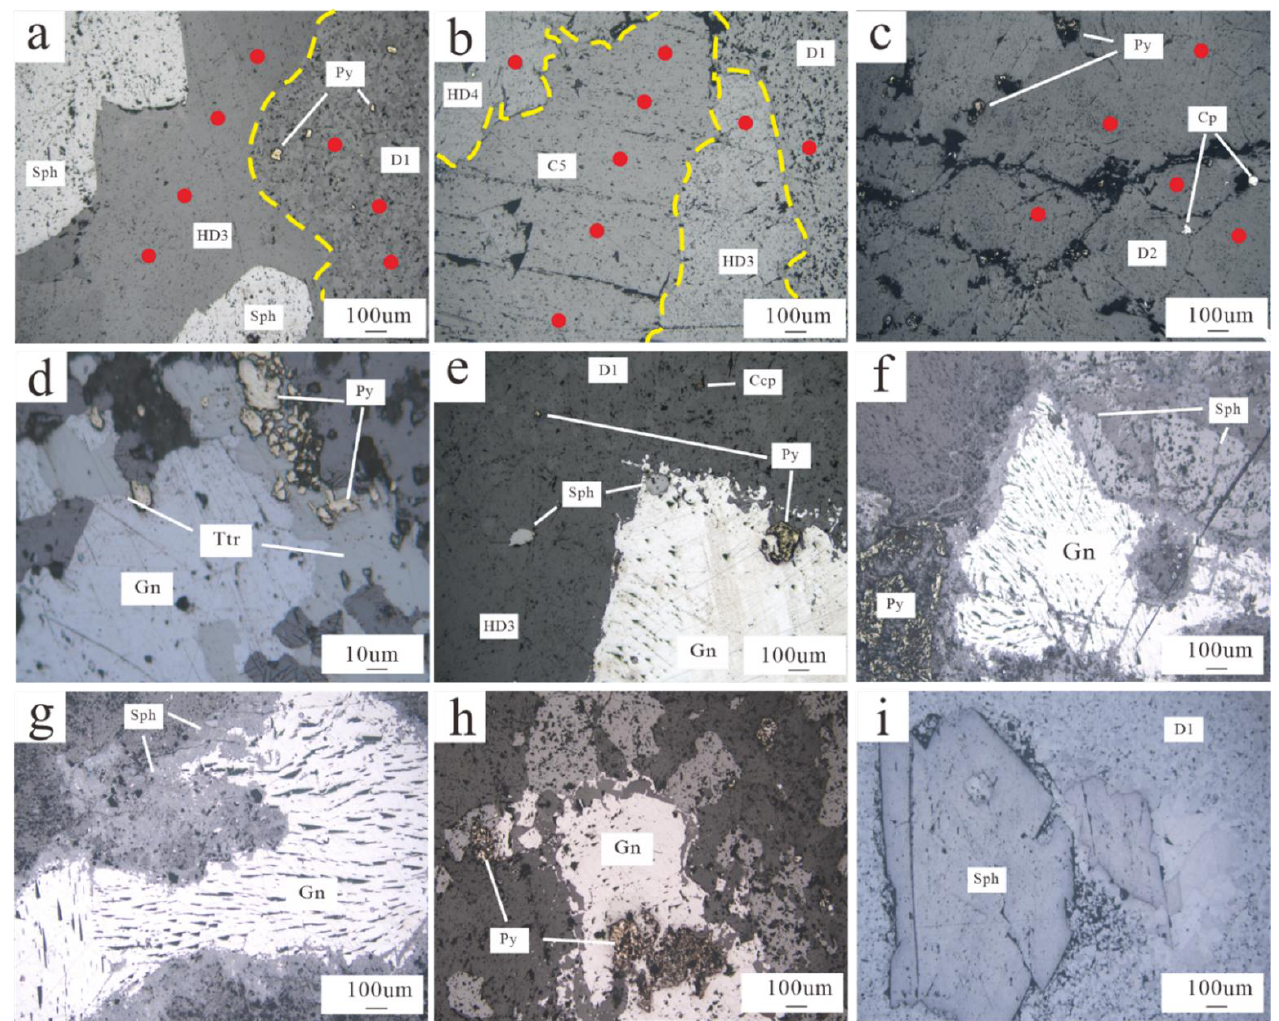
Figure 5. Textural features of minerals from the Fuli Pb-Zn deposit. The red dots represent laser ablation points, and the yellow lines are boundaries between different dolomites. ( a ) HD3 grey dolomite that coexists with sphalerite. ( b ) HD4 white dolomite and HD3 grey dolomite crosscut by euhedral calcite veins. ( c ) Pyrite and chalcopyrite observed as massive portions or disseminated in the D2 dolomite. ( d , e ) Galena metasomatic pyrite and/or tetrahedrite. ( f , g ) Contacts between sphalerite and galena showing embayment. ( h ) Metasomatic relict pyrite and xenomorphic sphalerite in anhedral sphalerite fracture. ( i ) Dolomite with a granular structure.